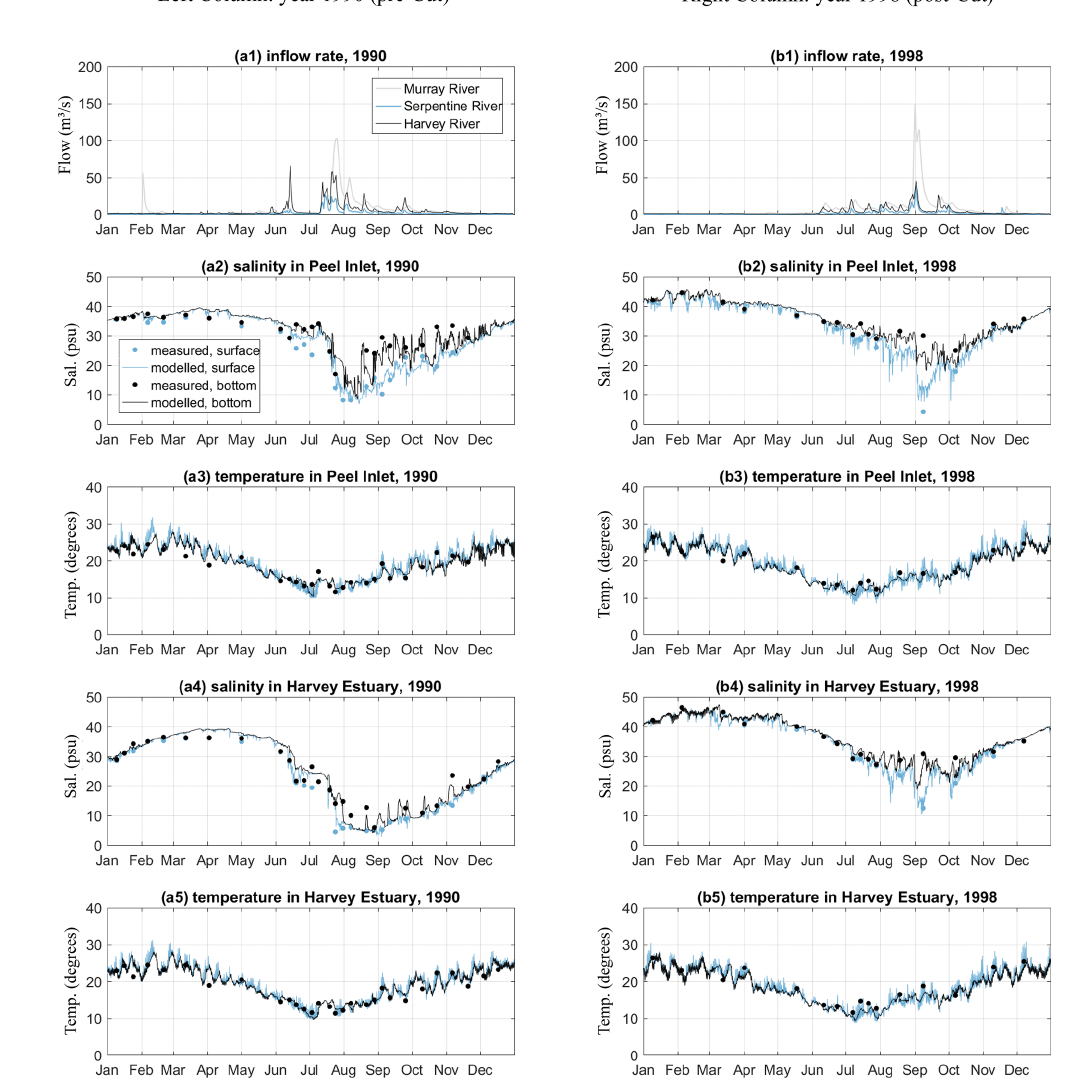
Figure 5. Annual variation in 1990 (left column, a ) and 1998 (right column, b ) of (1) inflow rate of the three main rivers, (2) monitored and modelled surface and bottom salinity at the centre of Peel Inlet (site PH7 in Fig. 1), (3) monitored and modelled surface and bottom water temperature at the centre of Peel Inlet, (4) monitored and modelled surface and bottom salinity at the centre of Harvey Estuary (site PH1 in Fig. 1), and (5) monitored and modelled surface and bottom water temperature at the centre of Harvey